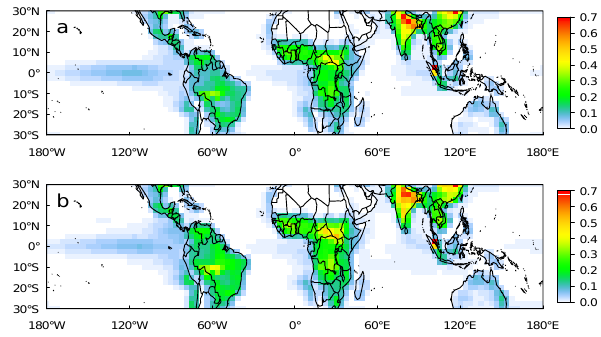
Fig. 9. Annual mean N 2 O flux (g m − 2 a − 1 N) from the inversion IAVA, shown for the tropics in the El Niño year 2002 (a) and the near-neutral year 2003 (b)